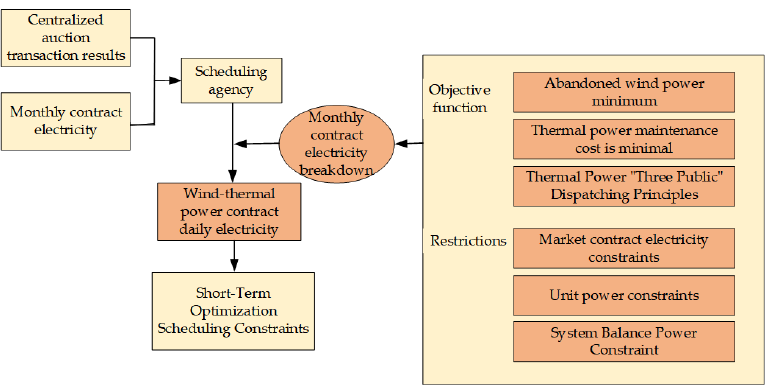
Figure 3. Decomposition of monthly contract electricity.